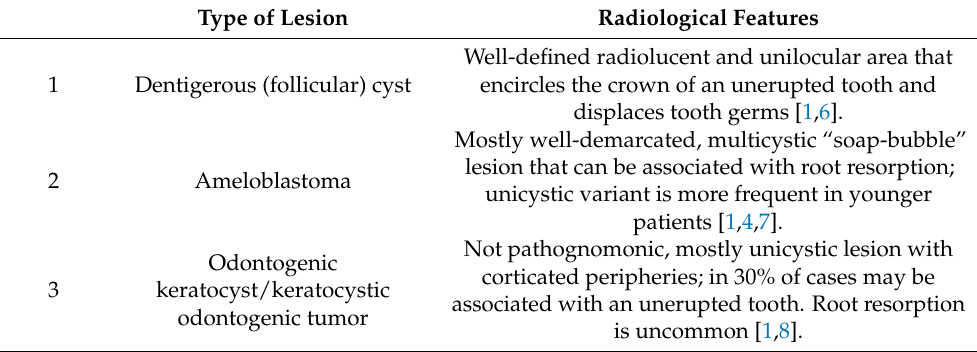
Table 1. The most frequent cyst and tumors associated with unerupted teeth in growing patients. Type of Lesion Radiological Features Well-defined radiolucent and unilocular area that 1 Dentigerous (follicular) cyst encircles the crown of an unerupted tooth